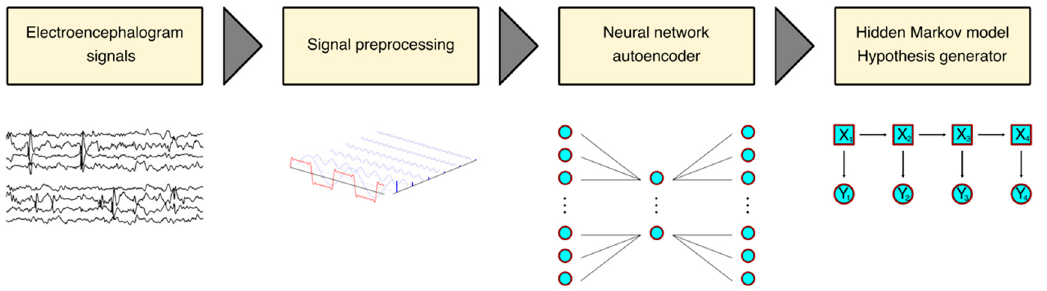
Figure 1. MindReader algorithm. From left to right, electroencephalographic (EEG) signals are loaded from standard European Data Format (EDF) files, then pre-processed by fast Fourier transform (FFT) and binned on overlapping windows. Next, signals are input to a neural network autoencoder where the autoencoder error is calculated, that is, the difference between the input and the autoencoder model post training is obtained, and considered anomaly. Finally, the signal is input to a hidden Markov model and hypothesis generator where states are assumed and labels are assigned. Importantly, the entire process is unsupervised and each channel is processed inde- pendently.